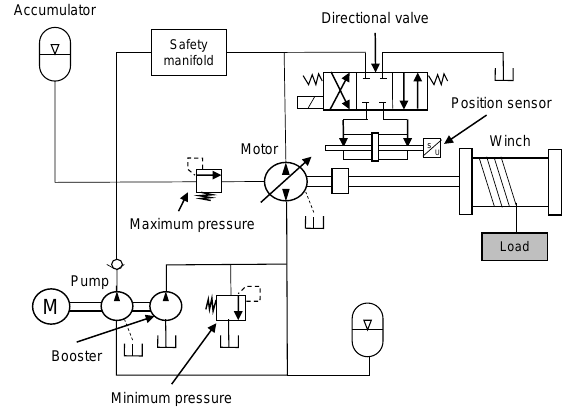
Figure 4: Schematic of a secondary controlled open- circuit hydraulic drive